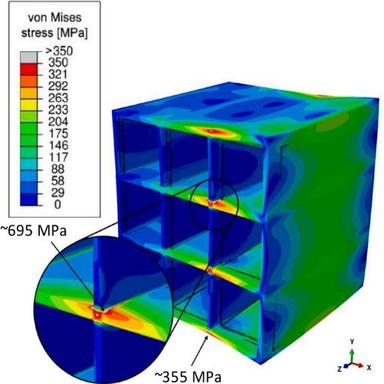
Swelling of ferritic-martensitic steel EUROFER97 and two varieties of ODS steels based on EUROFER 97 exposed to 16.3 dpa and shown as a function of temperature, measured using electron microscope observations of dislocation loops.